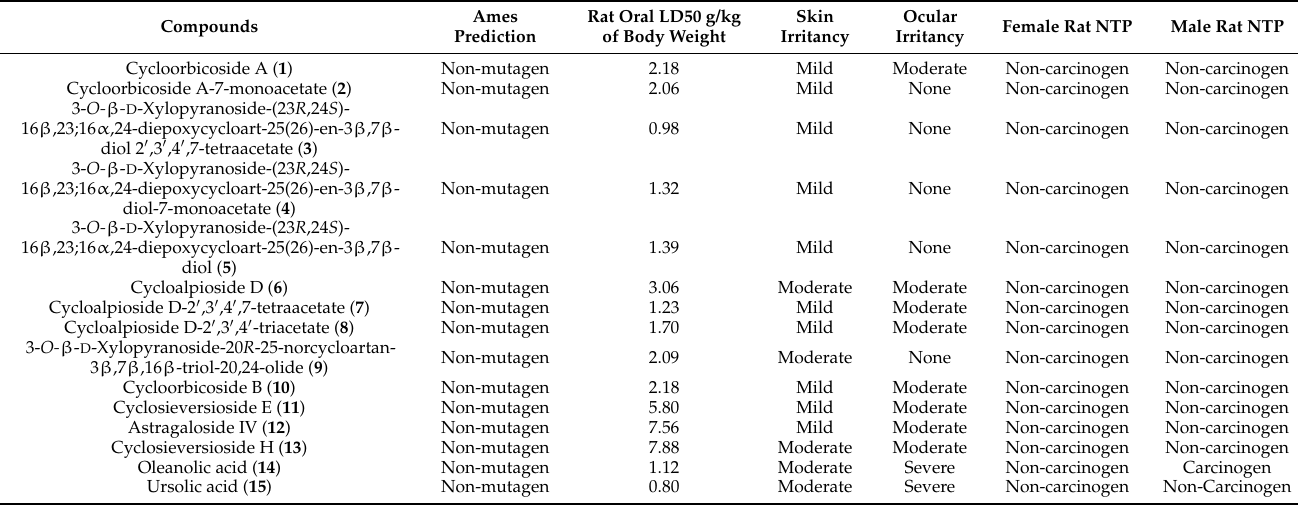
Table 5. TOPKAT analysis of the fifteen selected